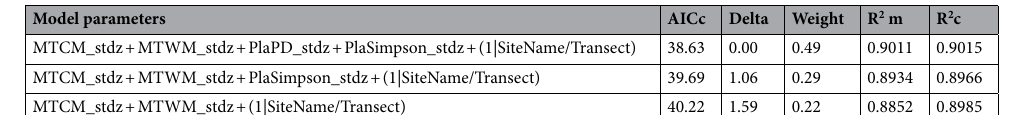
Table 1. Comparison of linear mixed-effect model fitted to the data on beetle Simpson diversity across the three regions in Yunnan province, SW China. AICc means Akaike Information Criteria (Corrected). Delta means AICc score differences. Weight refer to Akaike weights. Models with delta < 2 were presented and the top ranking model was the best. Conditional R 2 represents the variance explained by both fixed and random effects (R 2 c), and marginal R 2 refers to the variance explained by fixed effects only (R 2 m). The difference between these two components gives the R 2 of the random effect. The full model was: BeeSimpson_